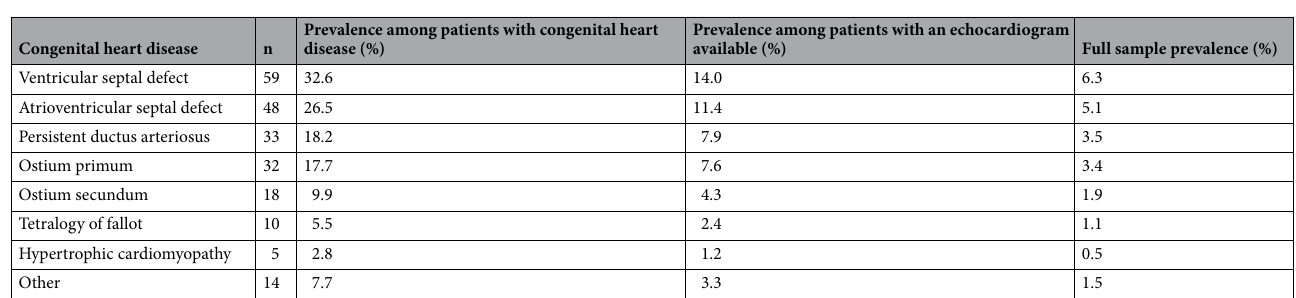
Table 2. Prevalence of congenital heart diseases in Spanish adults with Down syndrome.